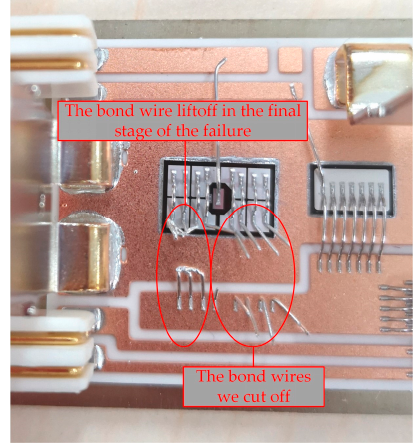
Figure 13. The final stage of bond wire failure.